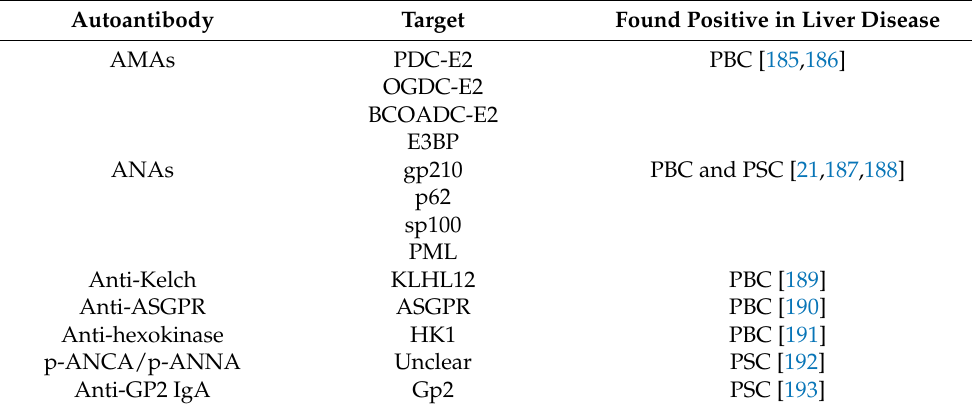
Table 1. Autoantibodies in PBC and PSC.